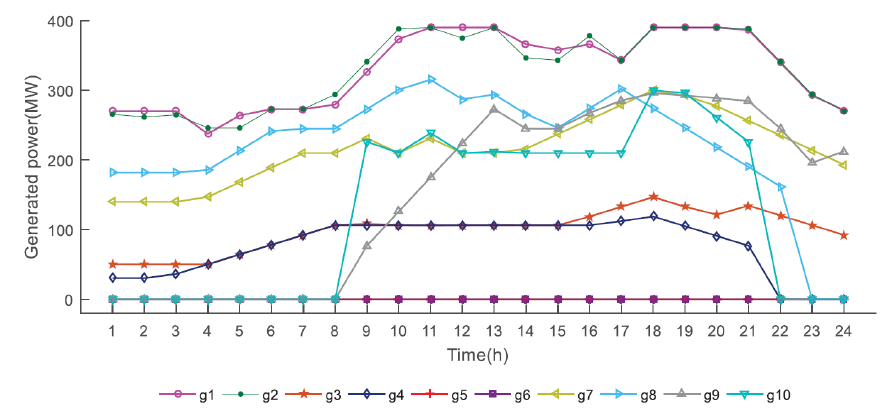
Figure 4. Injected active power of thermal generation units.